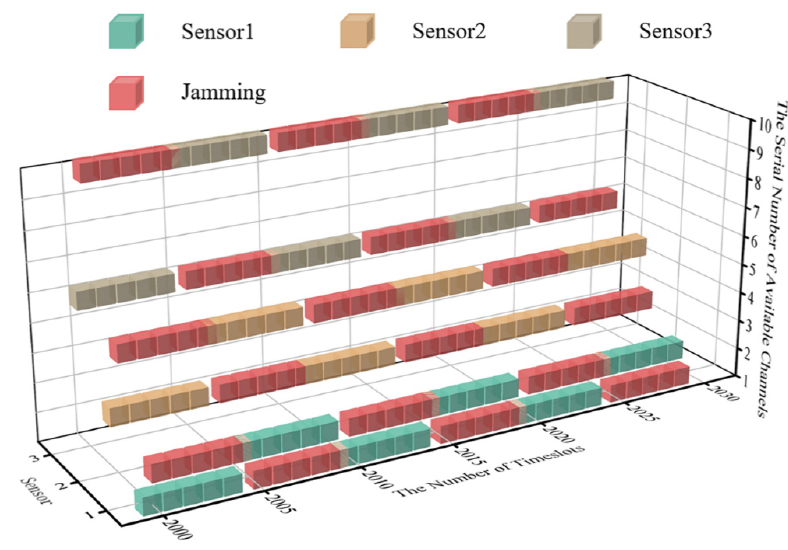
Figure 12. The cubic diagram of DAJA’s initial state with time delay.